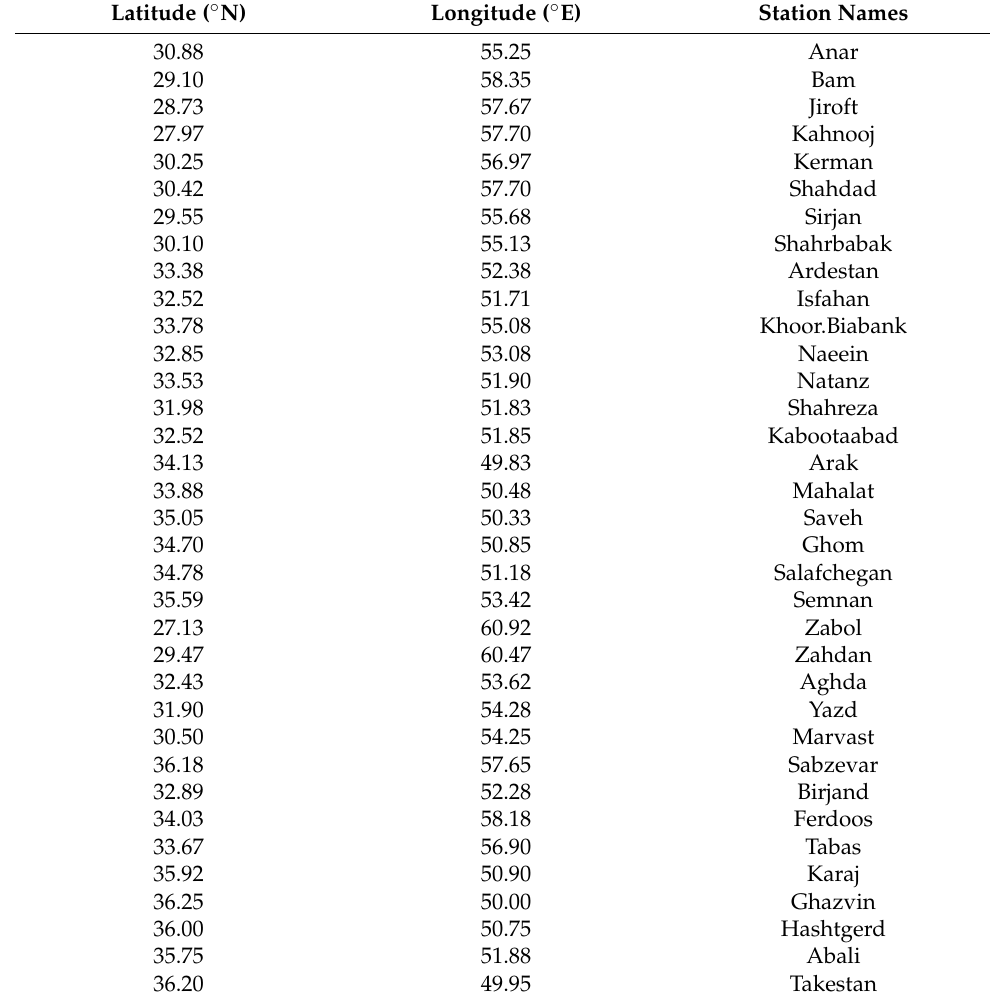
Table 1. Synoptic stations used in this